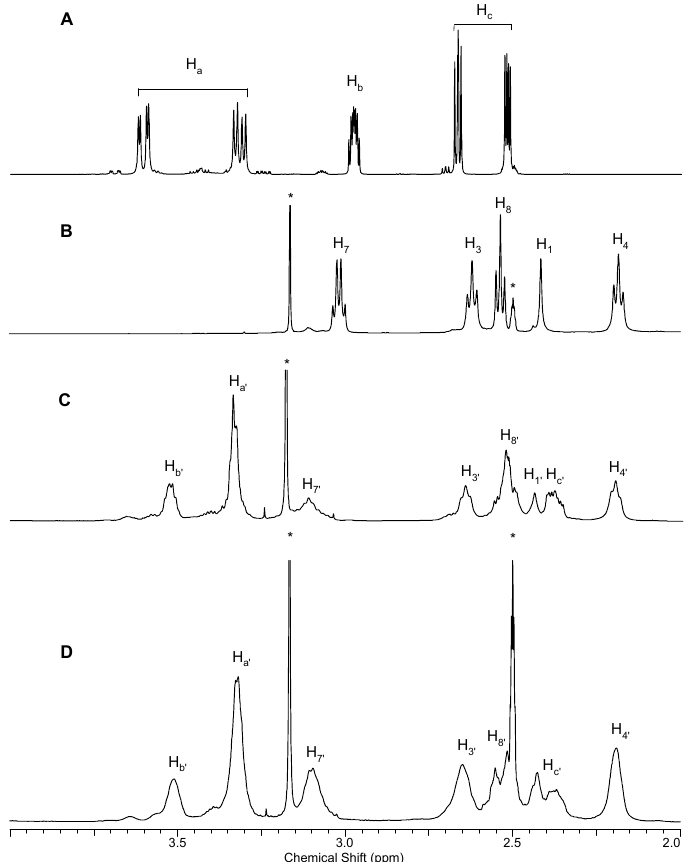
Figure 1. The relevant fragments of 1 H NMR spectra of: A —glycidol, B —PAMAM G0, C — G0 gl , and D — G3 gl in DMSO-d 6 . Resonances are labeled according to atom numbering in Scheme 1, Scheme 2, and Scheme 3. Residual CD 3 SOCD 2 H resonance and methanol are labeled with an asterisk. The 1 H resonances were assigned by COSY